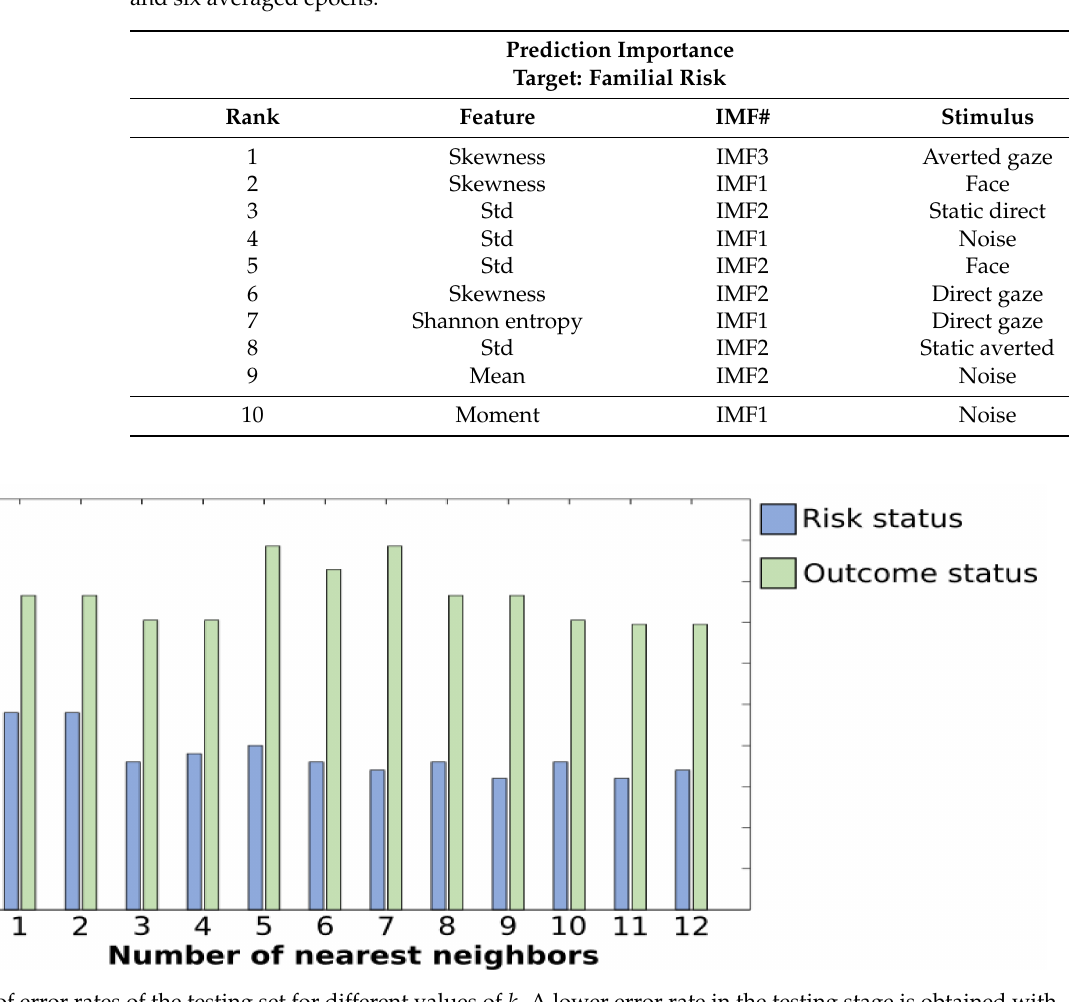
Figure 4. Plot of error rates of the testing set for different values of k . A lower error rate in the testing stage is obtained with k = 11 for the classification of the diagnosis outcome as well as for the classification of risk